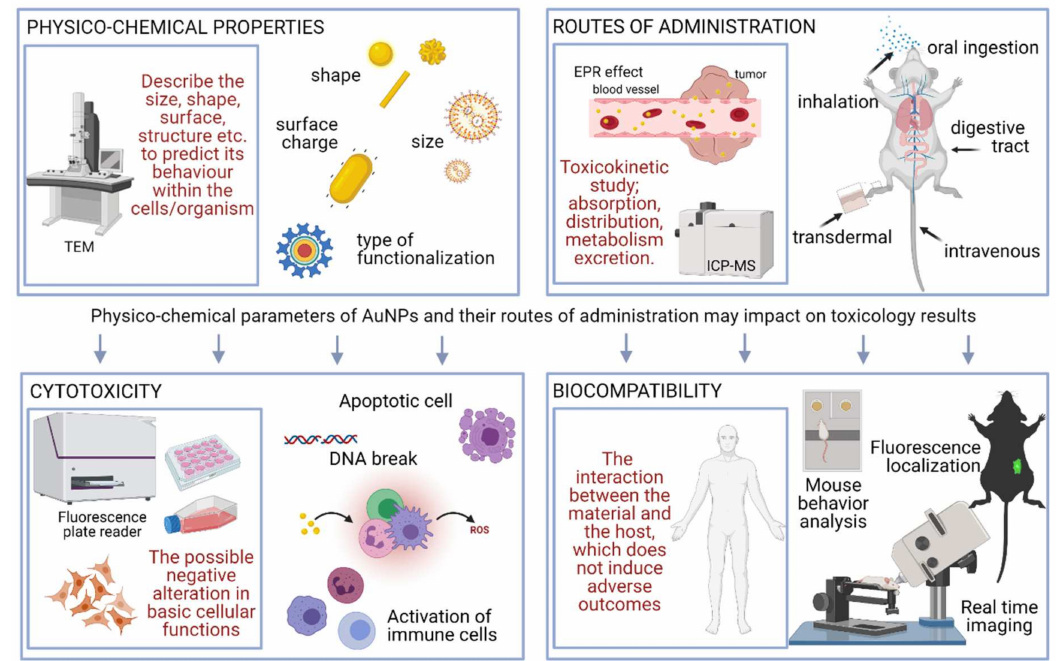
Figure 1. Schematic presentation of the various aspects of AuNPs (i.e., physicochemical characteristics and routes of administration) that impact their cytotoxicity and biocompatibility. For instance, size, shape, and the path by which the AuNPs are taken into the body (oral, transdermal, etc.) strongly influence toxicology and may cause adverse effects (apoptosis, ROS production, abnormalities in behaviour, etc.). These aspects may be measured on the cell or organism level. EPR, Enhanced Permeability and Retention effect; TEM, transmission electron microscope; ICP-MS, inductively coupled plasma mass spectrometry. Figure was created using Biorender (https://biorender.com, accessed on 6 October